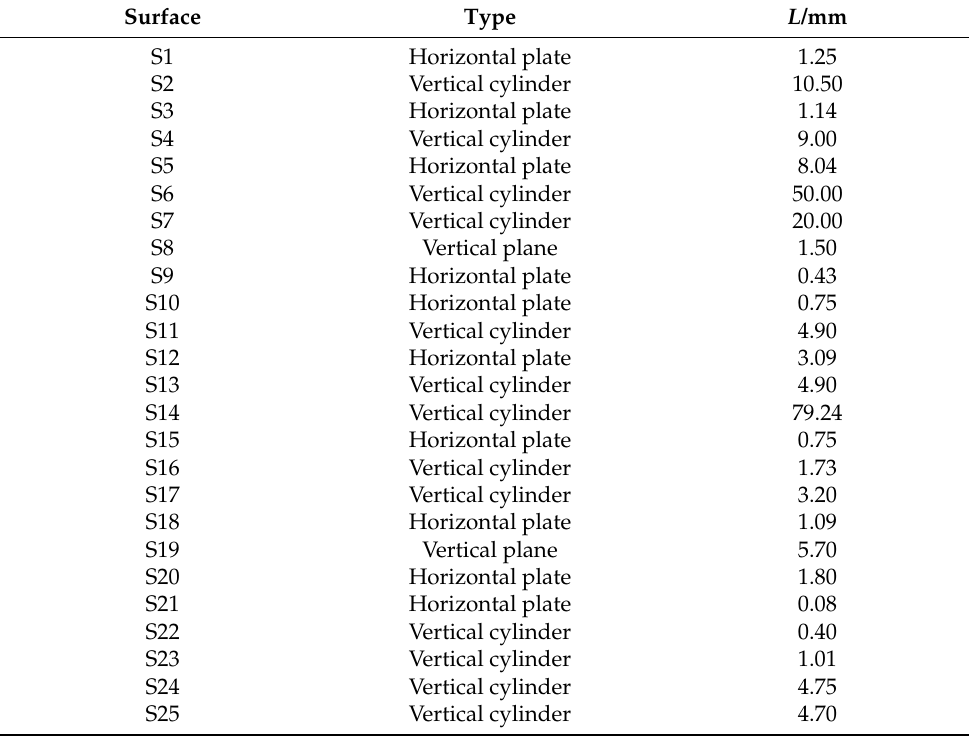
Figure 3. The numbering of external surfaces. Table 3. Calculated L values of each surface.